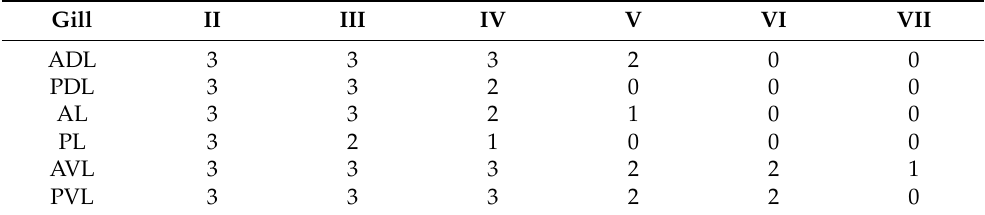
Table 5. Number of types of tracheal gills on abdominal segments II–VII of pupae of Limnephilus deqianensis n. sp. Positions abbreviated as: A = anterior, D = dorsal, L = lateral, P = posterior, V =